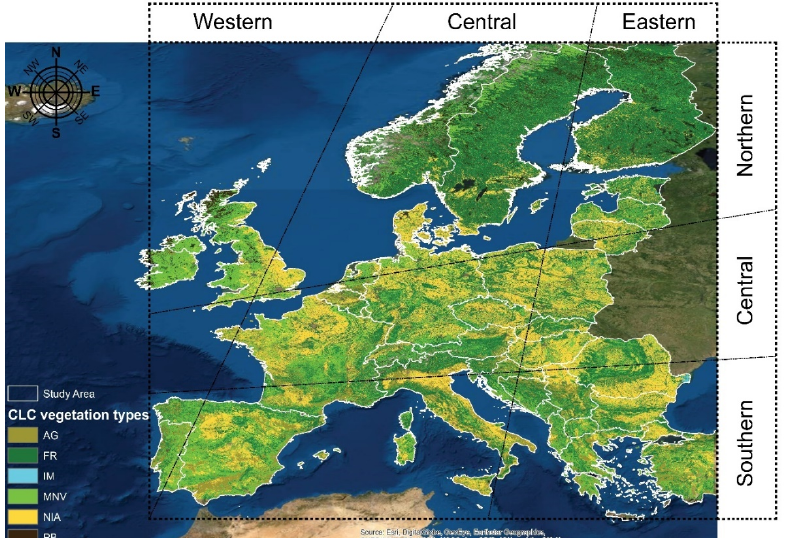
Figure 1. Map of the study area with six different vegetation types—agriculture (AG), forest (FR), inland marsh (IM), mixed natural vegetation (MNV), non-irrigated arable land (NIA), and peat bog vegetation (PB). Vegetation classes are derived from the CORINE Land Cover data set (CLC 2018), Land Monitoring Service, Copernicus Program (https://land.copernicus.eu/pan-european/corine-land-cover/clc2018). The white border indicates the study area. Background image source: Esri, DigitalGlobe, GeoEye, Earthstar Geographics, CNES/Airbus DS, USDA, USGS, AeroGRID, IGN, and the GIS User Community.